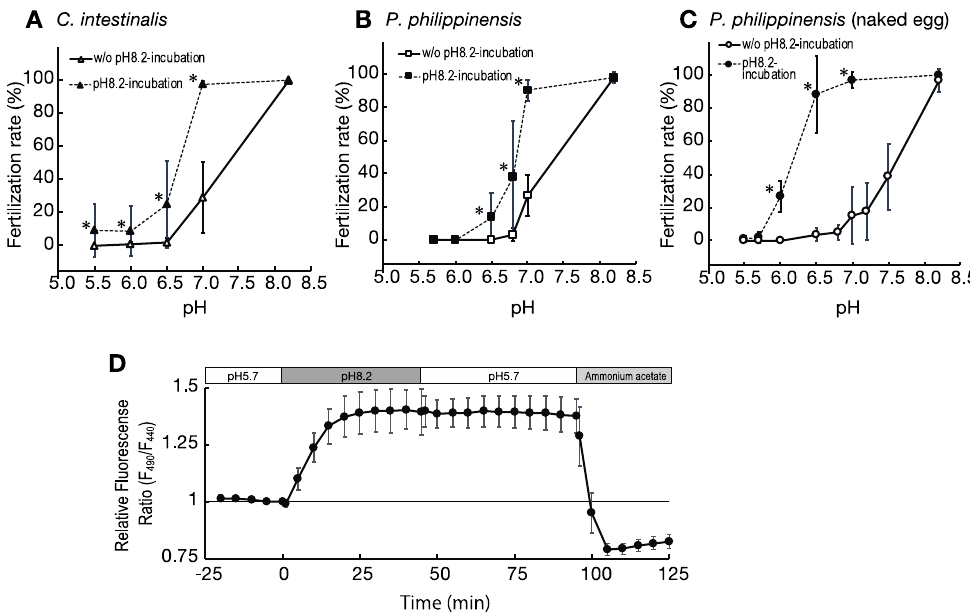
Figure 2. Effect of the pH on fertilization rates of eggs pre-incubated at pH 8.2 before insemination, in ascidians Ciona intestinalis ( A ) and Phallusia philippinensis ( B , C ). Closed marks show fertilization rates of eggs pre-incubated at pH 8.2 for 4 h. Open marks show fertilization rates of eggs pre-incubated in the insemination medium for 4 h. Values are expressed as the mean ± standard deviation (SD) of three to six experiments. Asterisks indicate the point that has statistical significance between the eggs with or without pH 8.2-incubation ( p < 0.05; Student’s t -test). ( D ) Intracellular pH changes in an egg were analyzed using the fluorescent pH sensor BCECF. Values are expressed as the mean ± SD of 15 eggs from three specimens. The ambient pH is indicated by the box in the upper part of the graph.